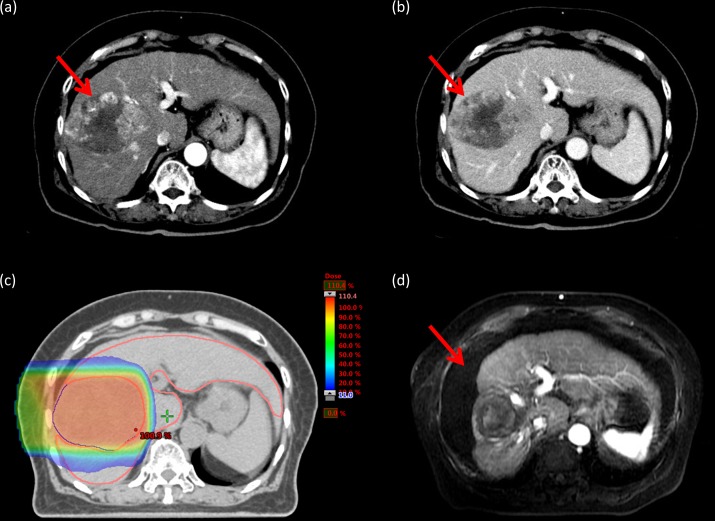
Tumor response of hepatocellular carcinoma diagnosed using imaging and alpha-fetoprotein (AFP) level.Pretreatment alpha-fetoprotein level of this patient was 86762.3 ng/mL. a. Arterial phase of the pretreatment dynamic computed tomography (CT) scan showing enhancement in the primary tumor (red arrow). b. The venous phase of the pretreatment dynamic CT scan showing early wash-out in the primary tumor (red arrow). c. The patient underwent proton beam therapy (PBT). d. Magnetic resonance imaging with contrast 25 months after PBT. Shrinkage and loss of tumor viability of the primary tumor (red arrow).